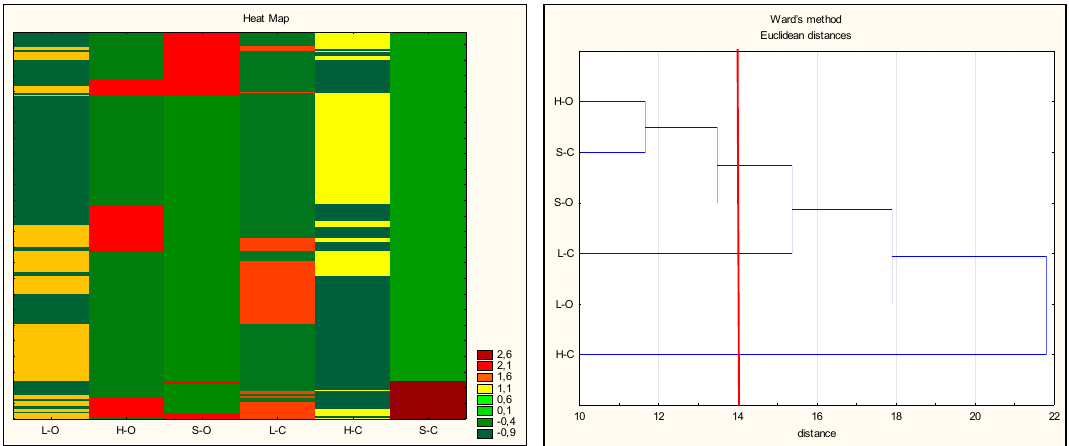
Figure 3. Heat map of abundance levels ( left ) and dendrogram ( right ) obtained as a result of hierarchical clustering based on proteomic data. The changes in abundance of statistically significant ( p < 0.05) spots among meat tissue models were analyzed. Fold change: negative values (decreasing abundance), 0 (no differences), positive values (increasing abundance); abbreviations: H-O: organic ham, L-O: organic loin, S-O: organic shoulder, H-C: conventional ham, L-C: conventional loin, S-C: conventional shoulder.